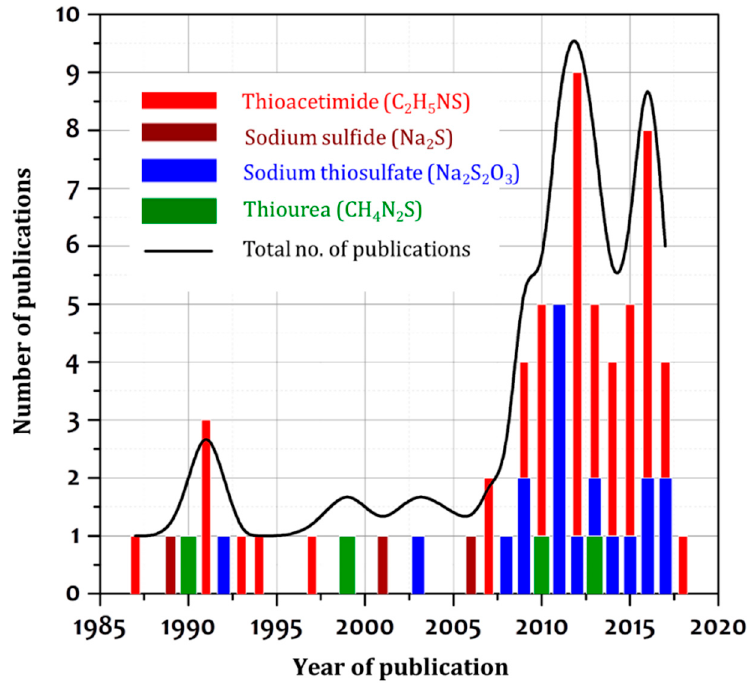
Figure 1. The number of chemical bath deposition (CBD) SnS reports on the usage of different sulfur precursors from 1980 to the present.